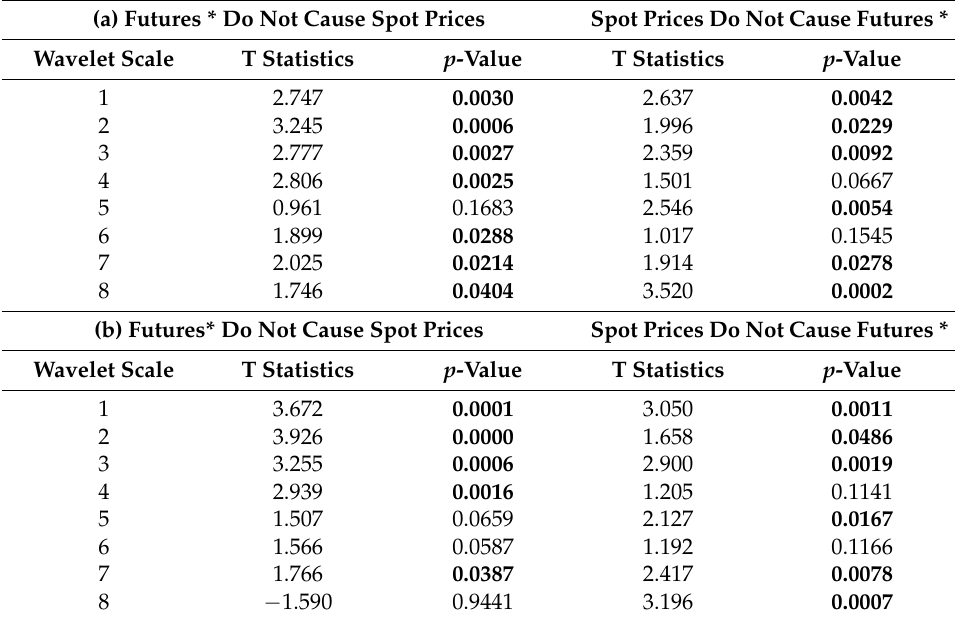
Table 6. Non-linear Granger causality test (MODWT